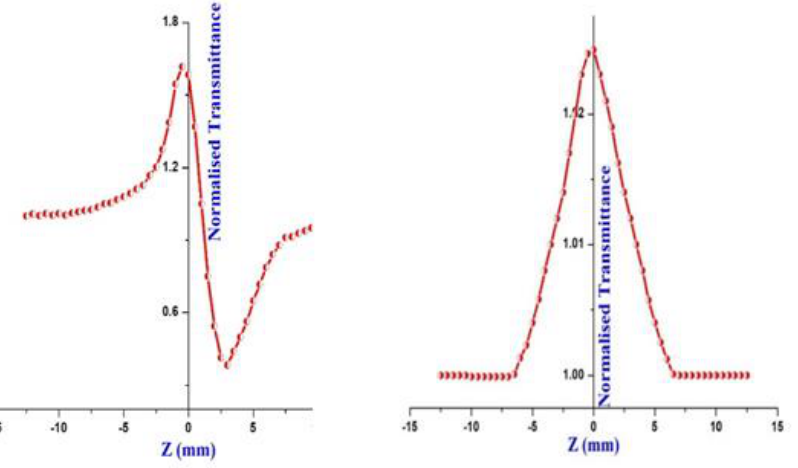
Figure 14. Closed and open aperture of